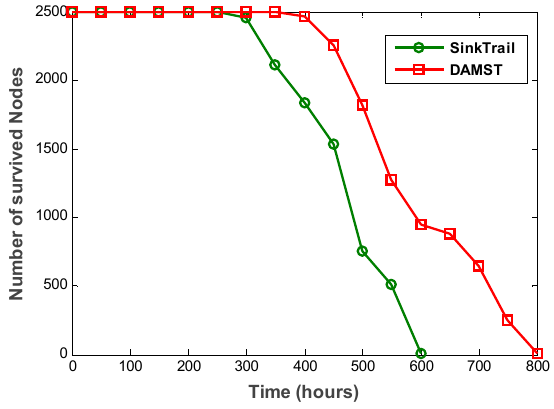
Figure 17. Numbers of survived nodes in DAMST and SinkTrail.